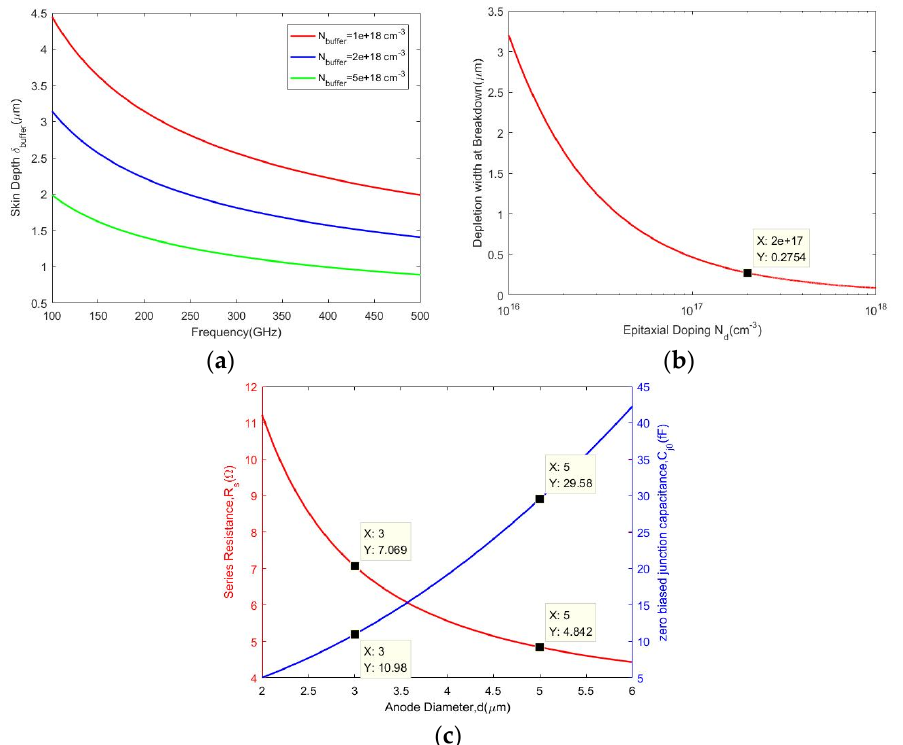
Figure 1. The simulation characteristics of the Schottky diode based on gallium arsenide material. ( a ) Skin depth of the buffer layer varies with frequency at different doping concentrations; ( b ) The thickness of the depletion layer varies with doping concentration of epitaxial layer; ( c ) Parameters of the Schottky junction vary with the anode diameter.